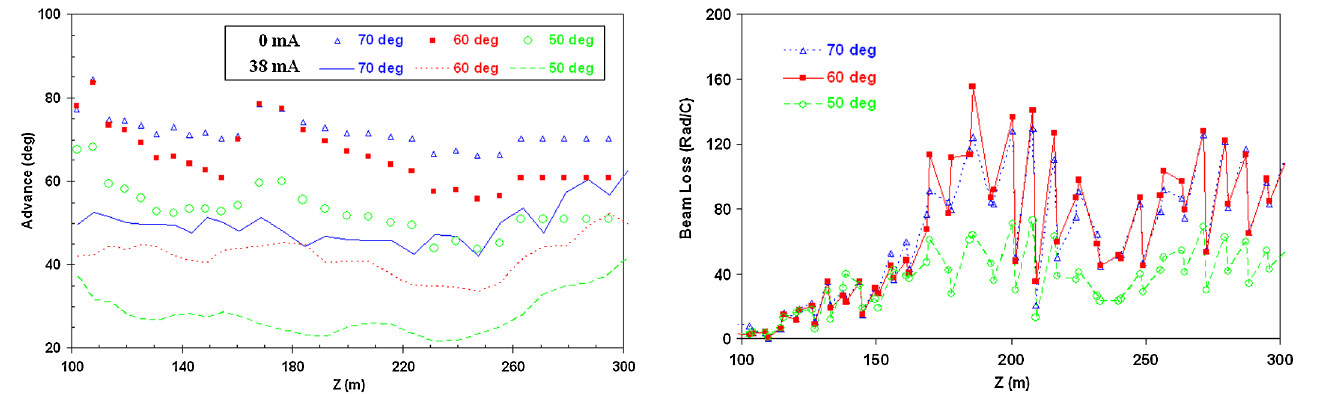
FIG. 8. (Color) Zero-current SCL phase advances at 50 (cid:1) , 60 (cid:1) , and 70 (cid:1) (marks), designed for the beam loss experiments; at 38 mA, space-charge depressed phase advances are 30 (cid:1) , 40 (cid:1) , and 50 (cid:1)